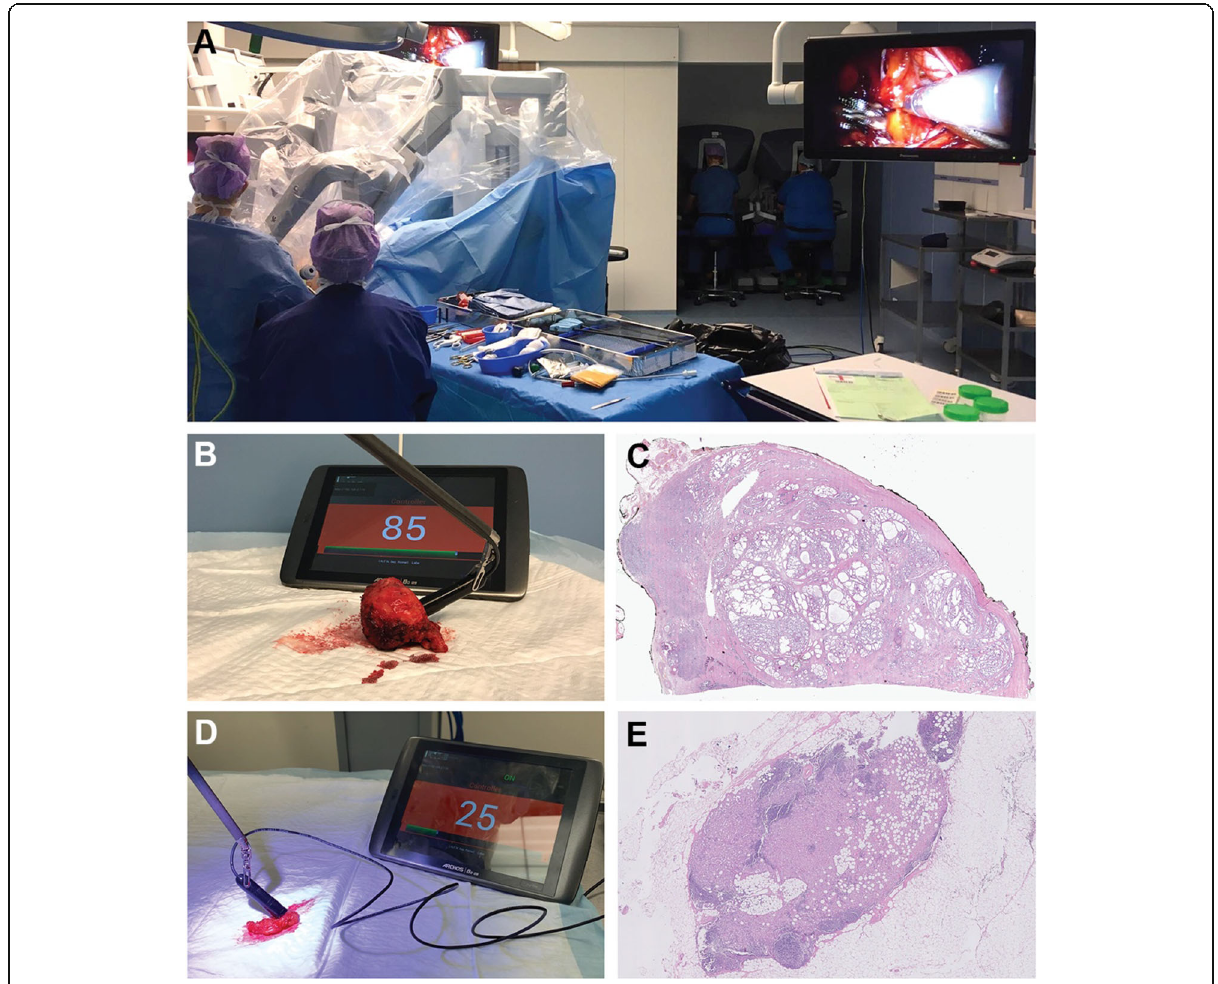
Fig. 3 DROP-IN β probe evaluation in relation to pathology. a Overview of the robot-assisted OR setup. b Example of robot-assisted beta-tracing with the DROP-IN β probe on the surface of a resected prostate sample. c Histopathology slide displaying tumor spread within the prostate with respect to the specimen surface. d Example of robot-assisted beta-tracing on the surface of a resected lymph node package. e Histopathology slide showing tumor spread within a PSMA-PET positive lymph